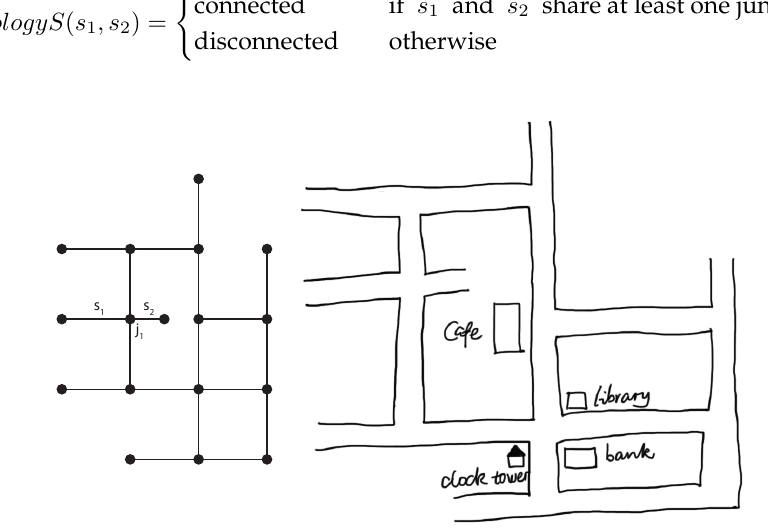
Figure 2: Street network (left) extracted from a new sketch map